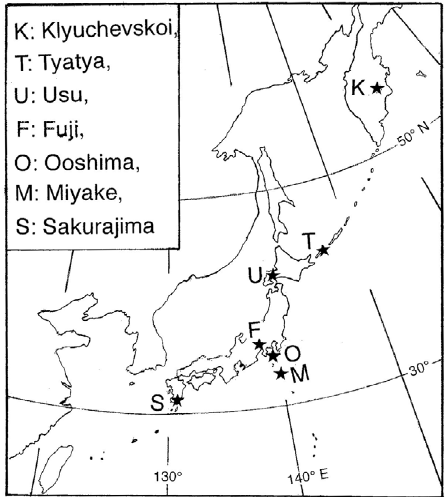
Figure 1. Location map in the eastern